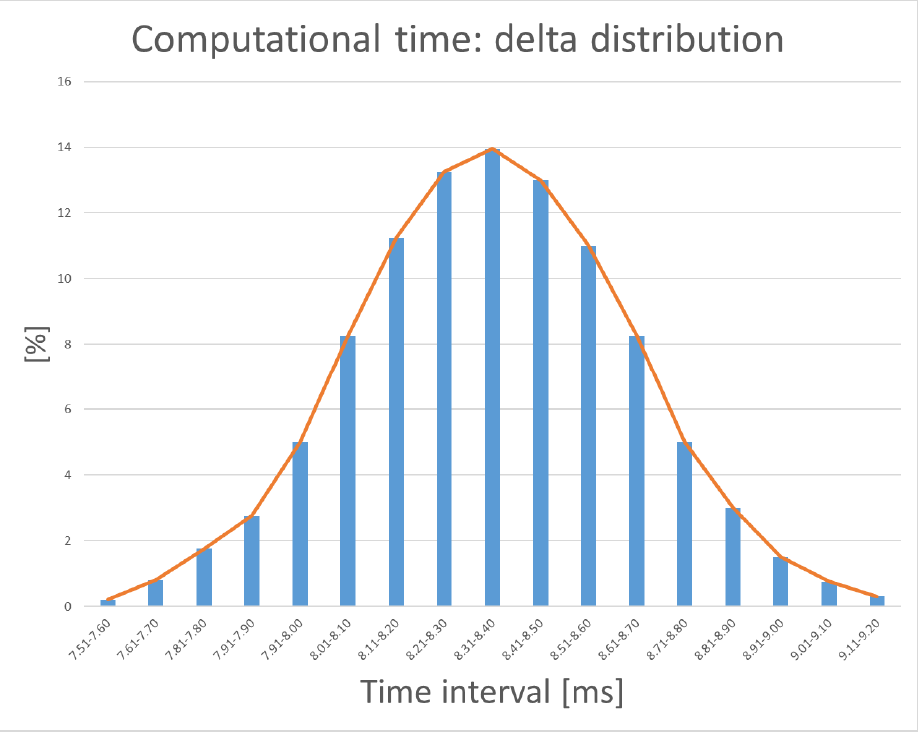
Figure 15. The statistical distribution of the delta computational time.